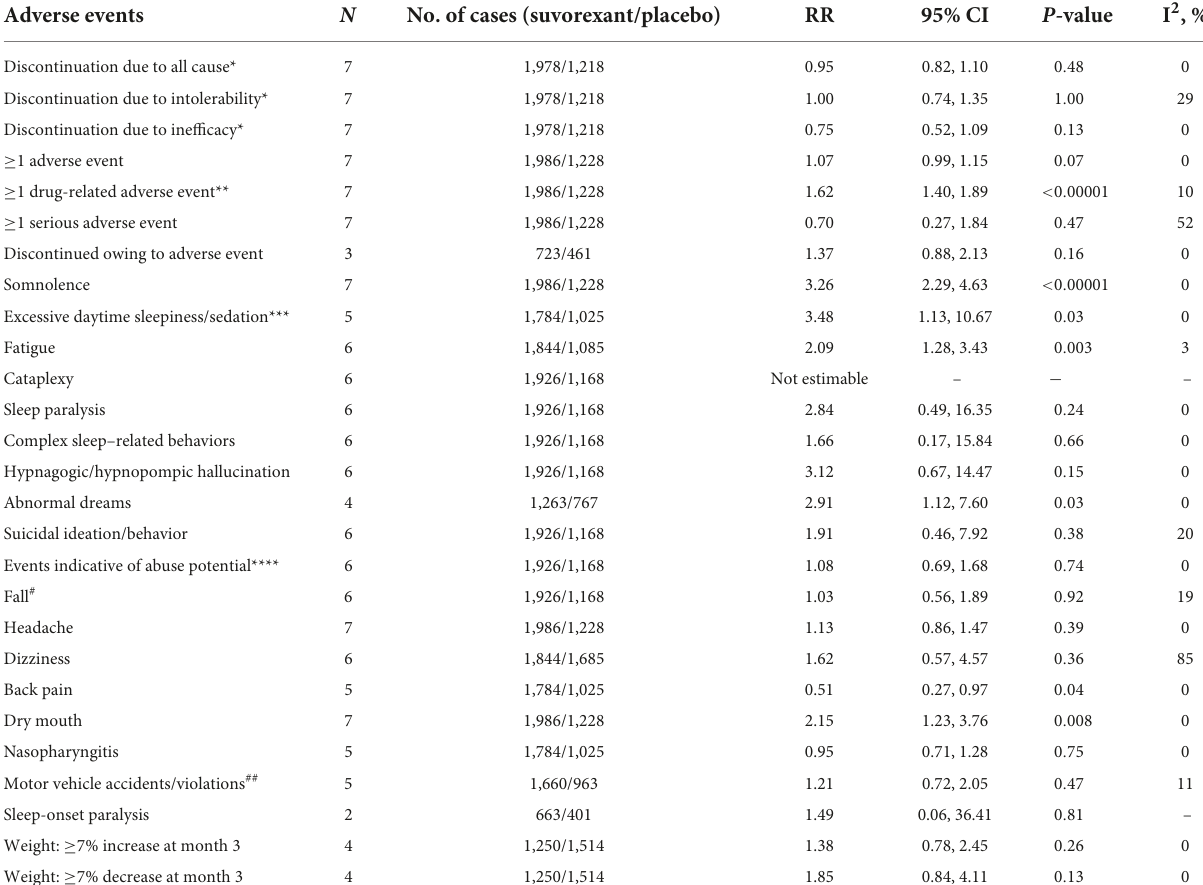
TABLE 4 Treatment discontinuation and individual adverse events for suvorexant vs.